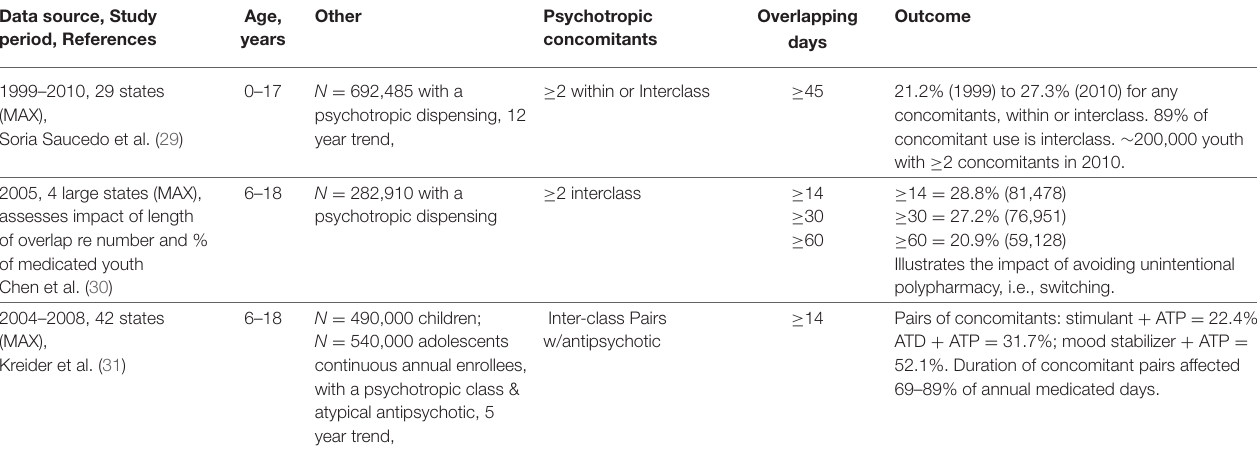
TABLE 2a | Pediatric psychotropic polypharmacy studies of publicly funded programs using medicaid analytic eXtract (MAX)